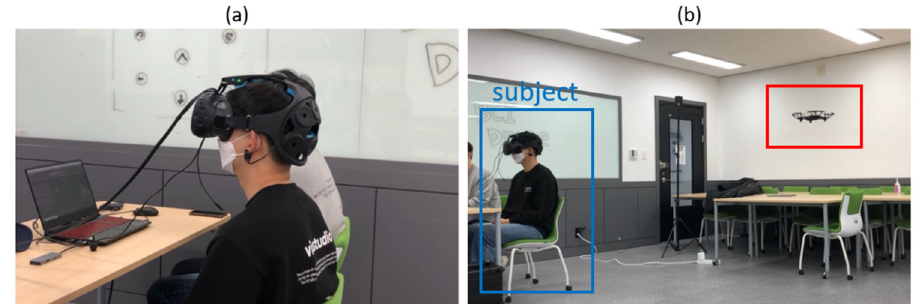
Figure 5. Experimental view. ( a ) A subject wearing HMD is playing the drone control system. ( b ) A real drone (red box) is being controlled by a subject (blue box) through the AR-drone control system.